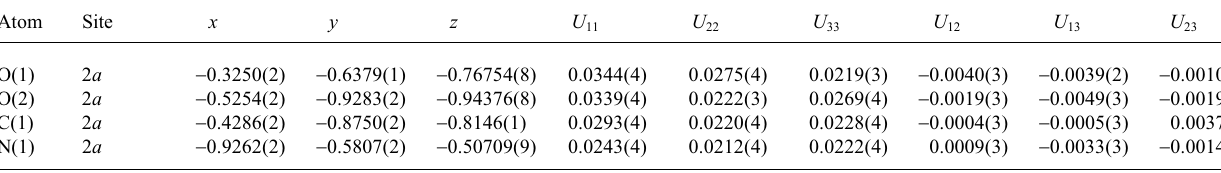
Table 3. Atomic coordinates and displacement parameters (in Å 2 )